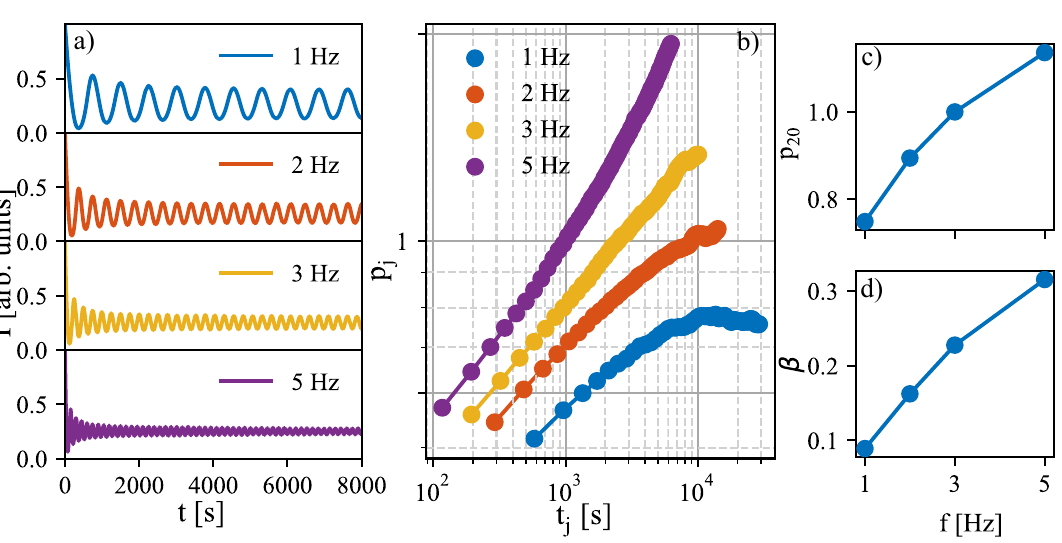
Figure 4. ( a ) Simulated AB intensities for simulations with different repetition frequencies f = 1, 2, 3, and 5 Hz. ( b ) The relative widths of individual level coverages fitted by tanh profiles. ( c ) The characteristic profile width p 20 and (d) the evolution of β with